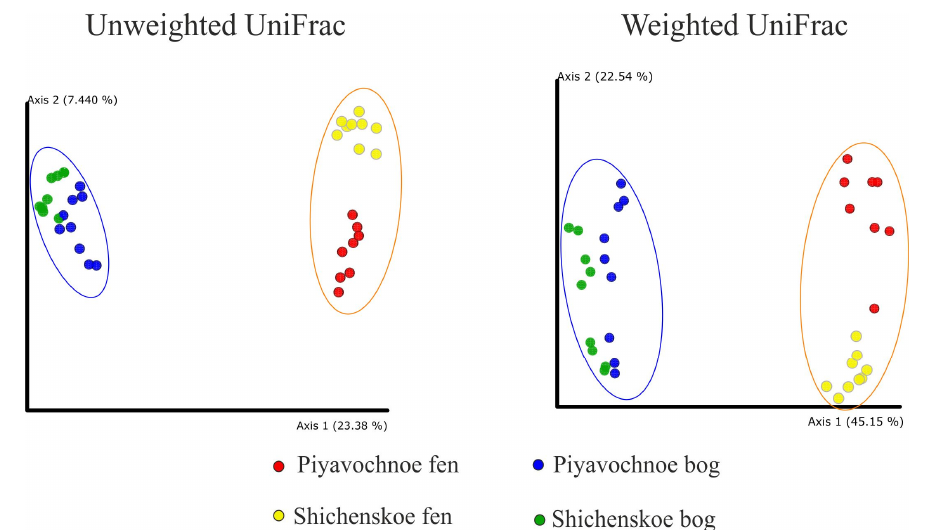
Figure 2. Comparison of the microbial community composition in peat samples examined in this study by principle coordinate analyses (PCoA). PCoA plot is based on the weighted and unweighted UniFrac distance of the sequencing dataset. The significance of differences between the microbial community compositions in bogs and fens is confirmed with p ≤ 0.001 for both weighted and unweighted UniFrac matrices.